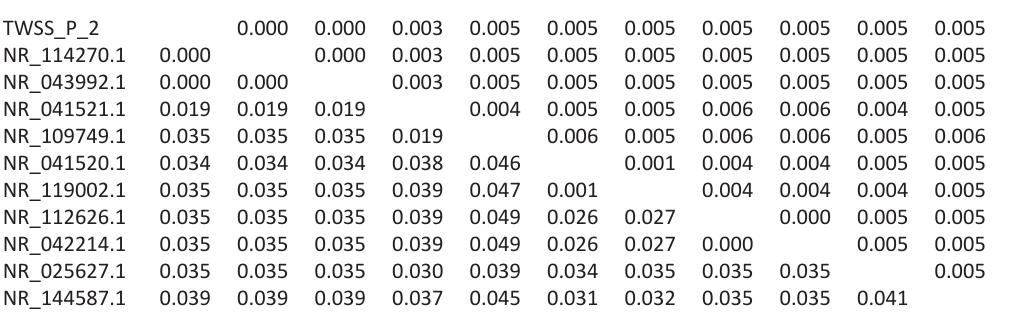
Table 6. Estimates of evolutionary divergence between the sequences considered for this